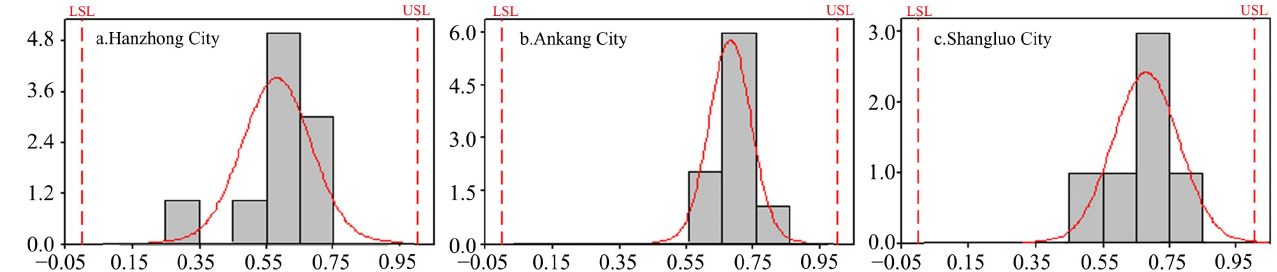
Figure 11. Differences of SDP among counties within three